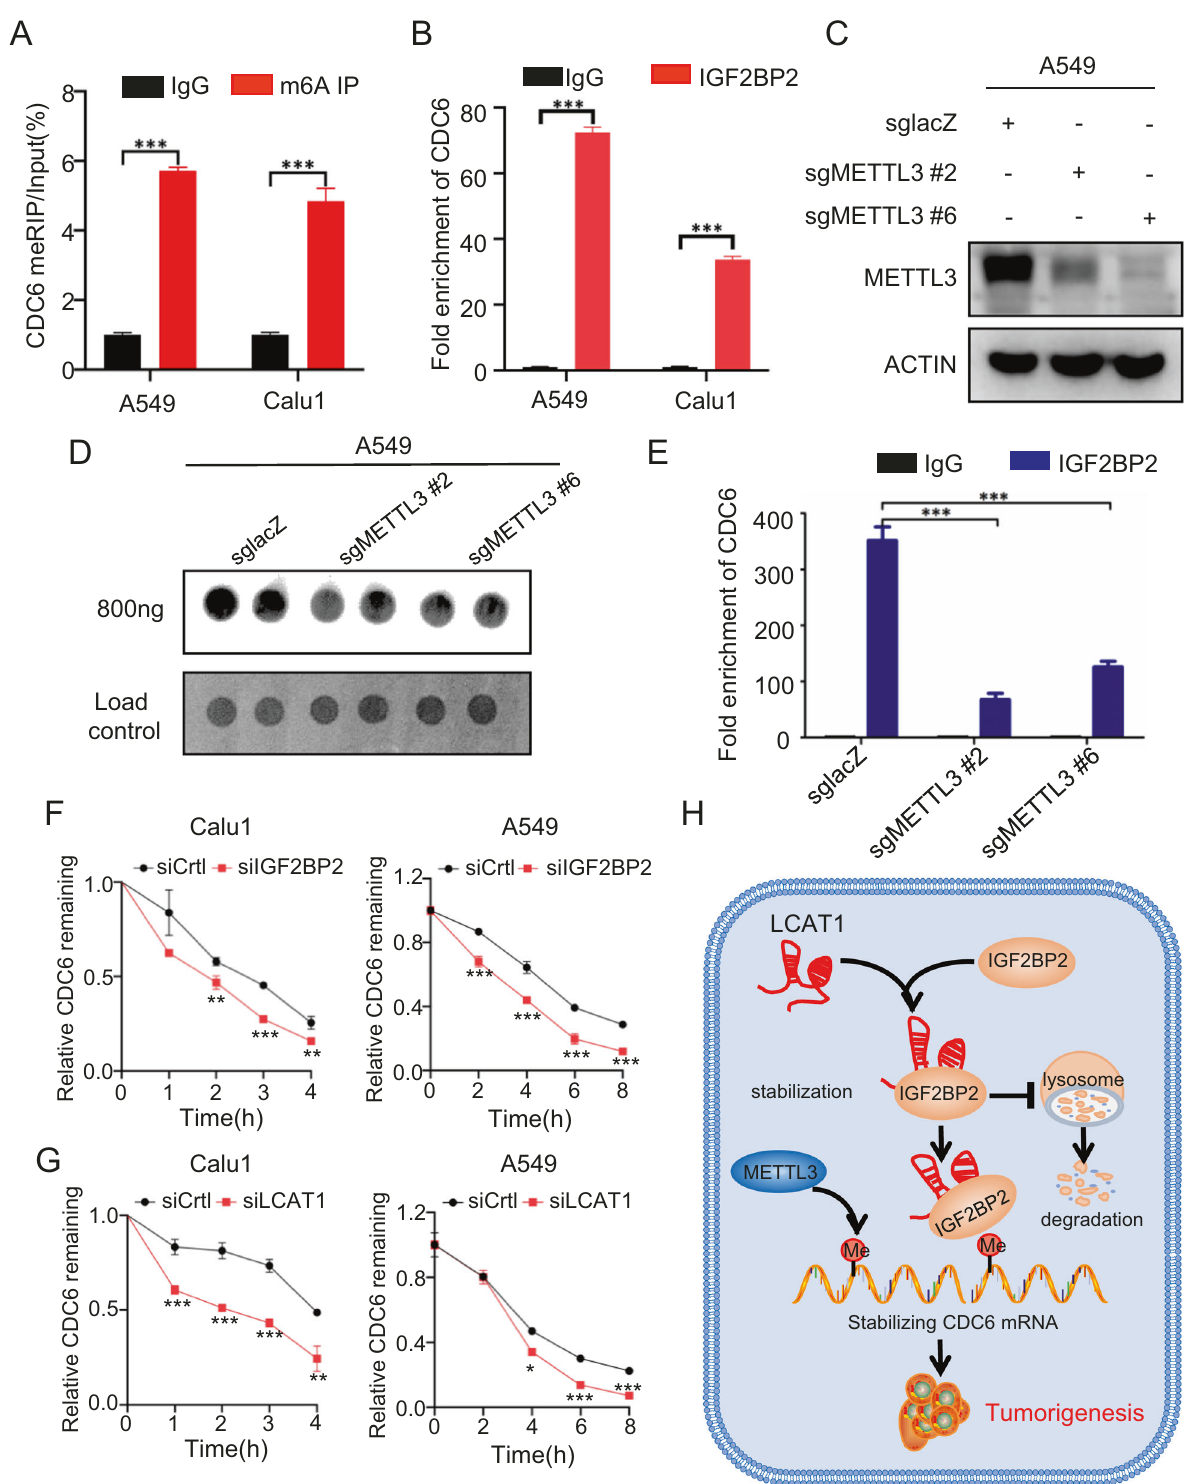
Fig. 6 LCAT1/IGF2BP2 enhances CDC6 mRNA stability via an m 6 A-dependent manner. A MeRIP-qPCR was performed to determine the enrichment of m 6 A-modi fi ed CDC6 RNA in anti-m 6 A and IgG groups. B RIP-qPCR was conducted to evaluate the enrichment of CDC6 in anti- IGF2BP2 antibody and IgG antibody groups. C Western blot of METTL3 knockout in A549 cells. D Dot blot assay indicated that knockout of METTL3 decreased global levels of m 6 A modi fi cation. E RIP-qPCR was performed in METTL3 knockout A549 cells using an anti-IGF2BP2 antibody or IgG antibody. F , G Depletion of IGF2BP2 ( F ) or LCAT1 ( G ) reduced CDC6 RNA stability in lung cancer cells. Cells were fi rst transfected with IGF2BP2 siRNA or LCAT1 siRNA, then treated with 2 μ g/ml actinomycin D at different time points. H Schematic diagram of the LCAT1-IGF2BP2-CDC6 axis in mediating lung cancer pathogenesis. * P < 0.05, ** P < 0.01, *** P <